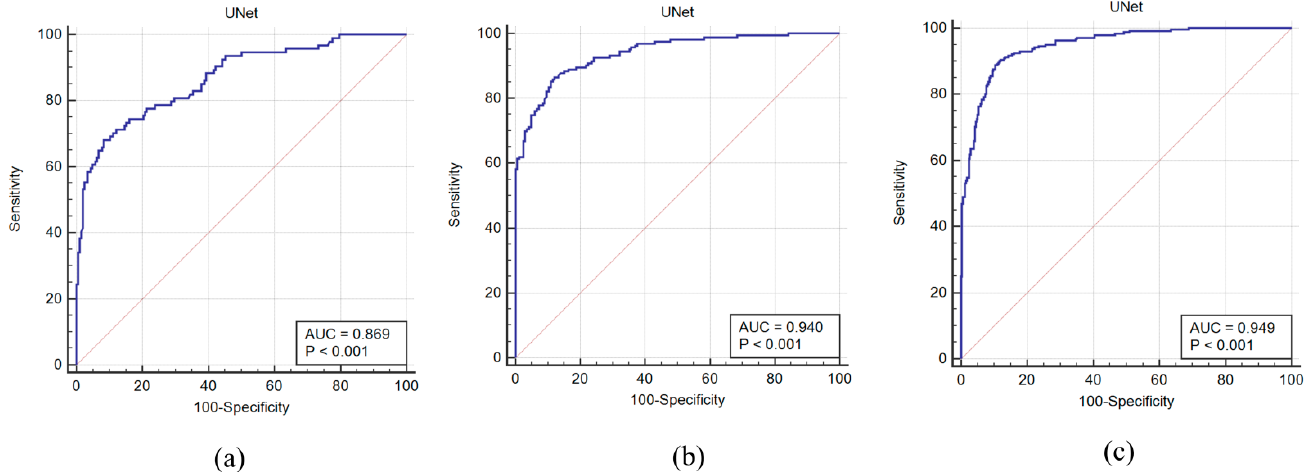
Figure 7. Receiver operating characteristics (ROC) curves and AUCs for the Unseen AI and Seen AI experiments. ( a ) Experiment #1 (Unseen AI-1 (Tr: JAP, Te: HK)) ( b ) experiment #2 (Unseen AI-2 (Tr: HK, Te: JAP)) ( c ) experiment #3 (Seen AI-1 CV w/ Mixed).